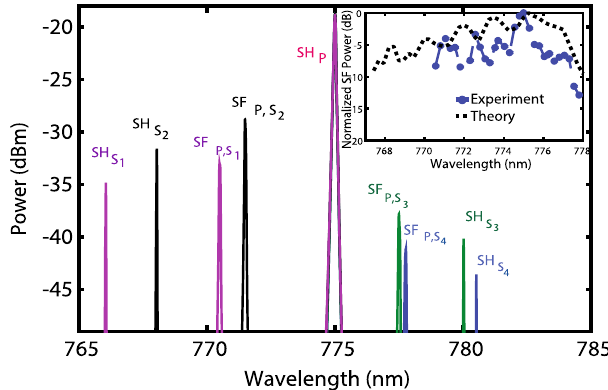
Figure 4. Overlaying of four experimentally observed spectra including SH of a pump (SHP) at λ 1 = 1550 nm and SH of four tuned signals at λ S1 = 1532 nm, λ S2 = 1536 nm, λ S3 = 1560 nm and λ S4 = 1561 nm named as SH S1 , SH S2 , SH S3 and SH S4 and SF of the pump and signals presented by SF P,S1 , SF P,S2 , SF P,S3 and SF P,S4 . The inset shows theoretical and experimental results for normalized SF power versus wavelength demonstrating the tunability of the device over > 8 nm.